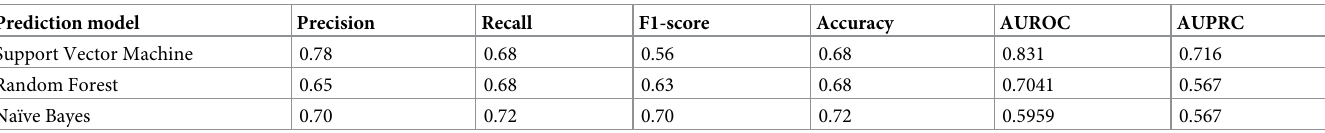
Table 4. Summary of the comparison of IgAN without ’Crescent proportion’ and ’Global crescent proportion’ model performance. Prediction model Precision Recall F1-score Accuracy AUROC AUPRC Support Vector Machine 0.78 Random Forest